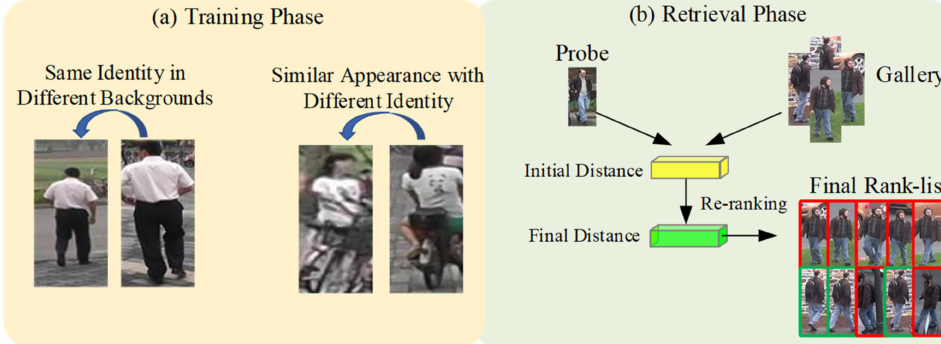
Figure 1. The challenges of background variations for person